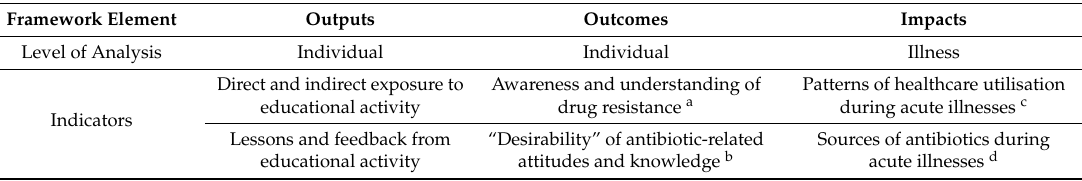
Table 4. Evaluation framework for analysis of study outcomes.